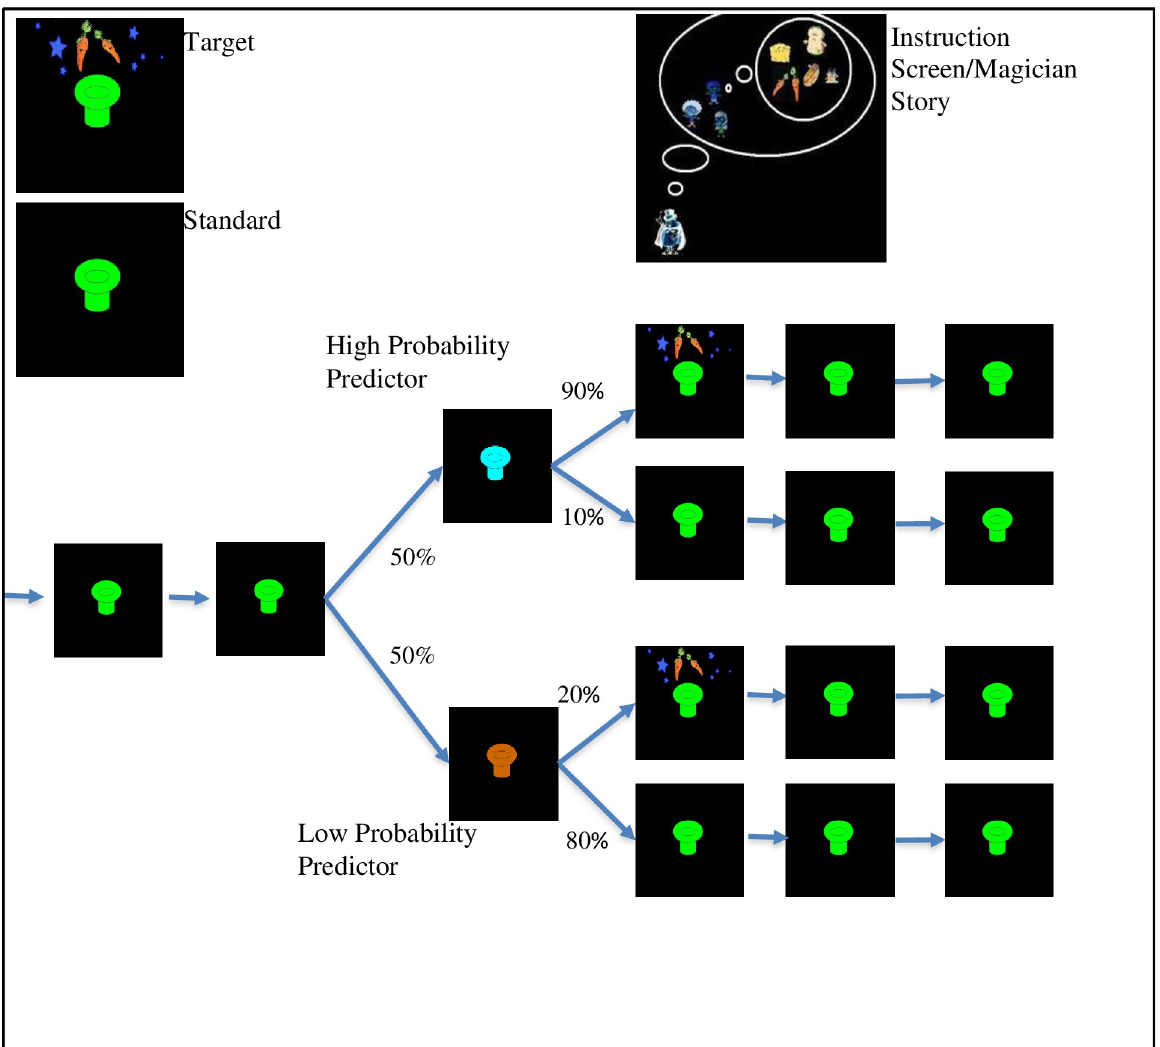
Fig 1. Schematic representation of the statistical learning task. The low predictor and high predictor stimuli were presented with equal frequency (i.e., the same number of trials); however, the target followed the high predictor on 90% of high predictor trials but only followed the low predictor on 20% of low predictor